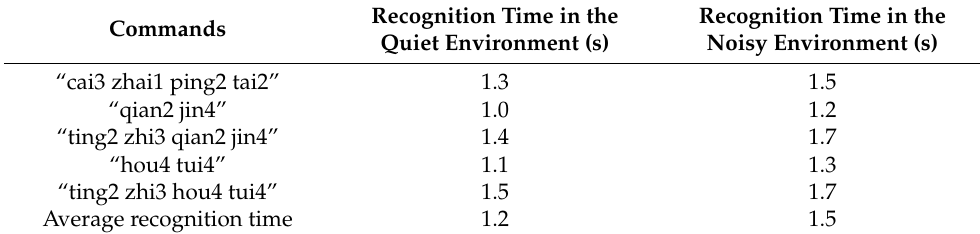
Table 9. Recognition time of the walking voice system in the two environments. Recognition Time in Commands